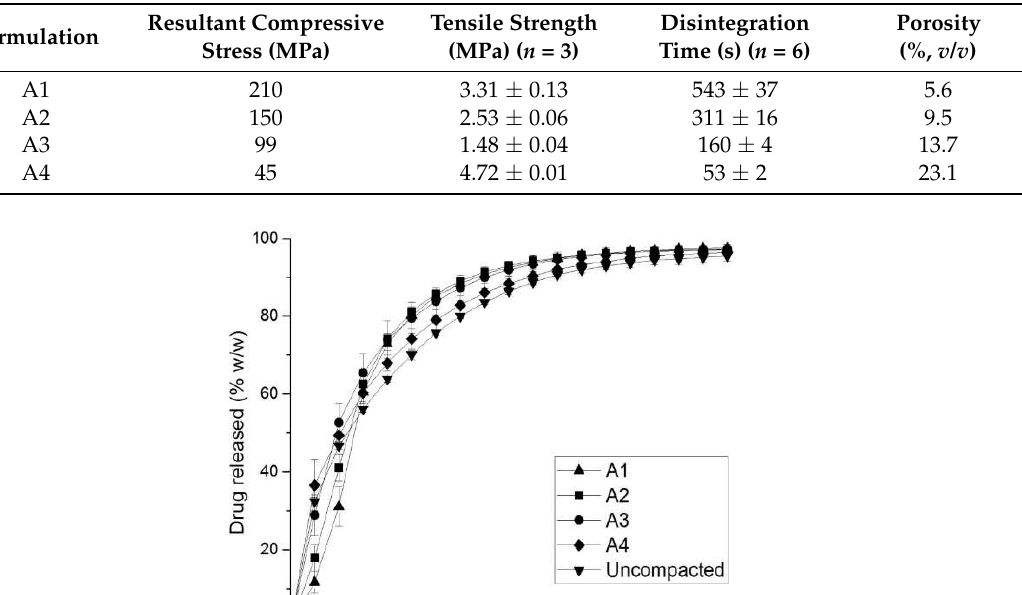
Table 3. Tablet properties and compaction condition.